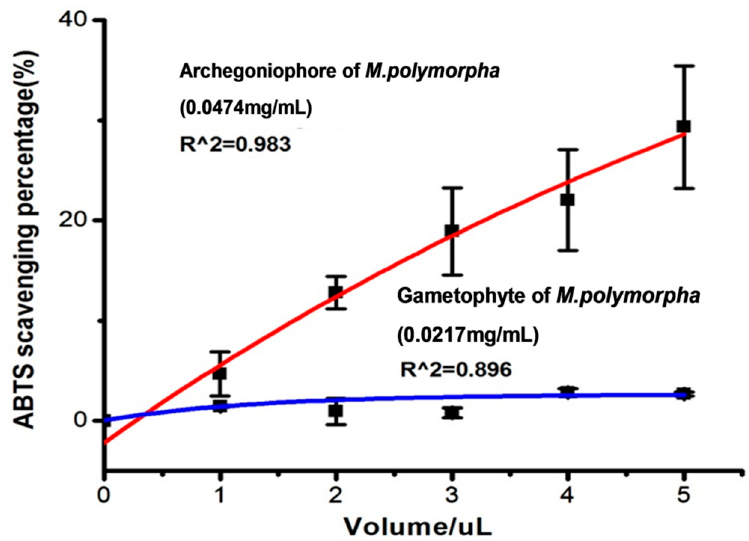
Figure 3. The ABTS radical scavenging potential of flavonoids extract from gametophyte and archegoniophore of M. polymorpha L . ( n = 3).